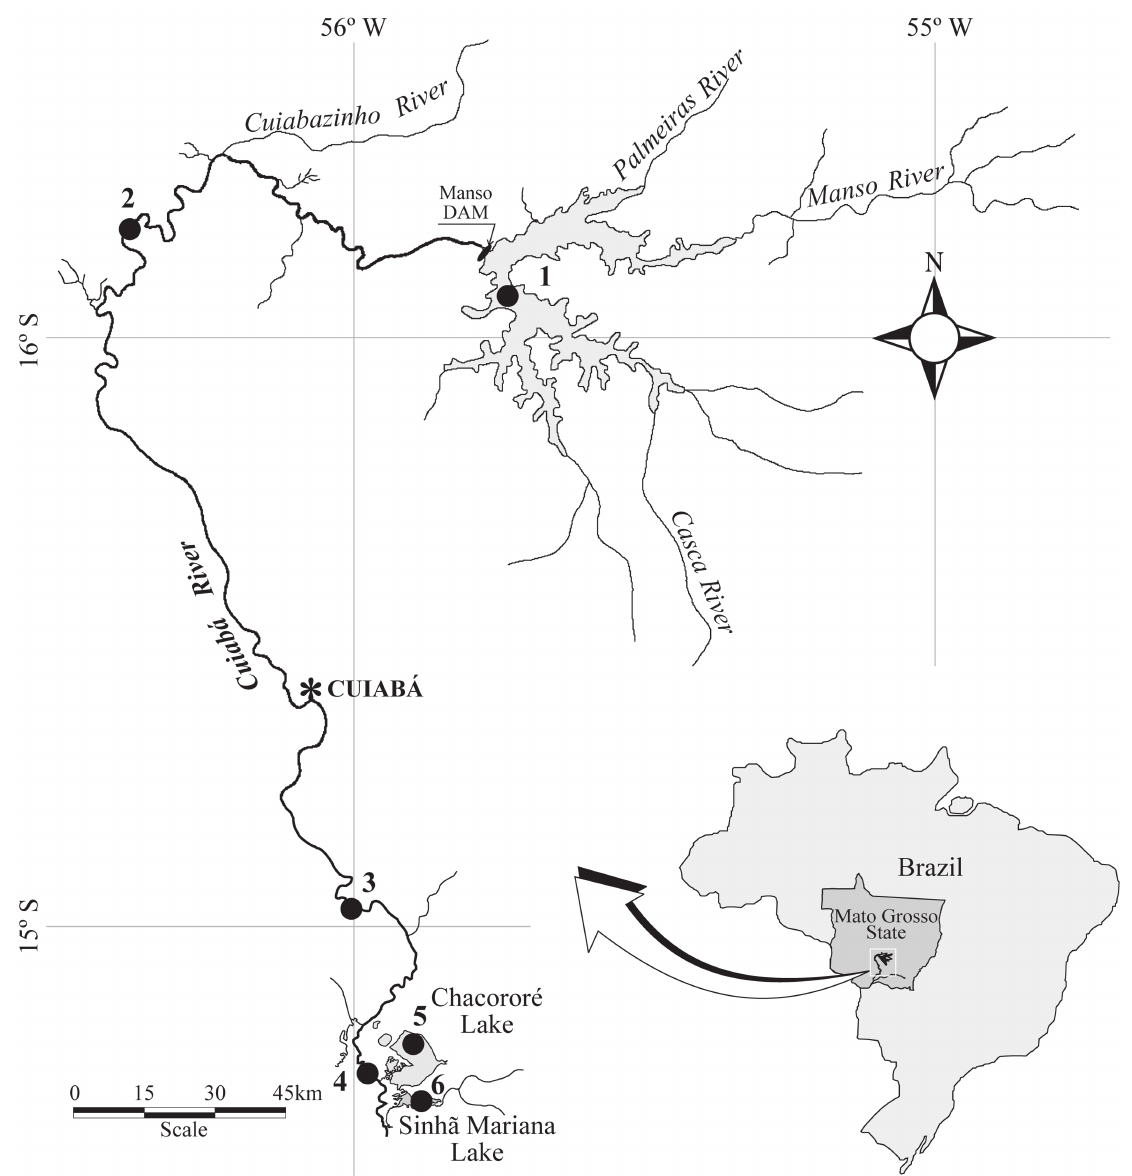
Fig. 1 . Location of the Cuiabá River basin, Mato Grosso, Brazil, and the sampling sites: lotic (2, 3 and 4) and lentic (1, 5 and